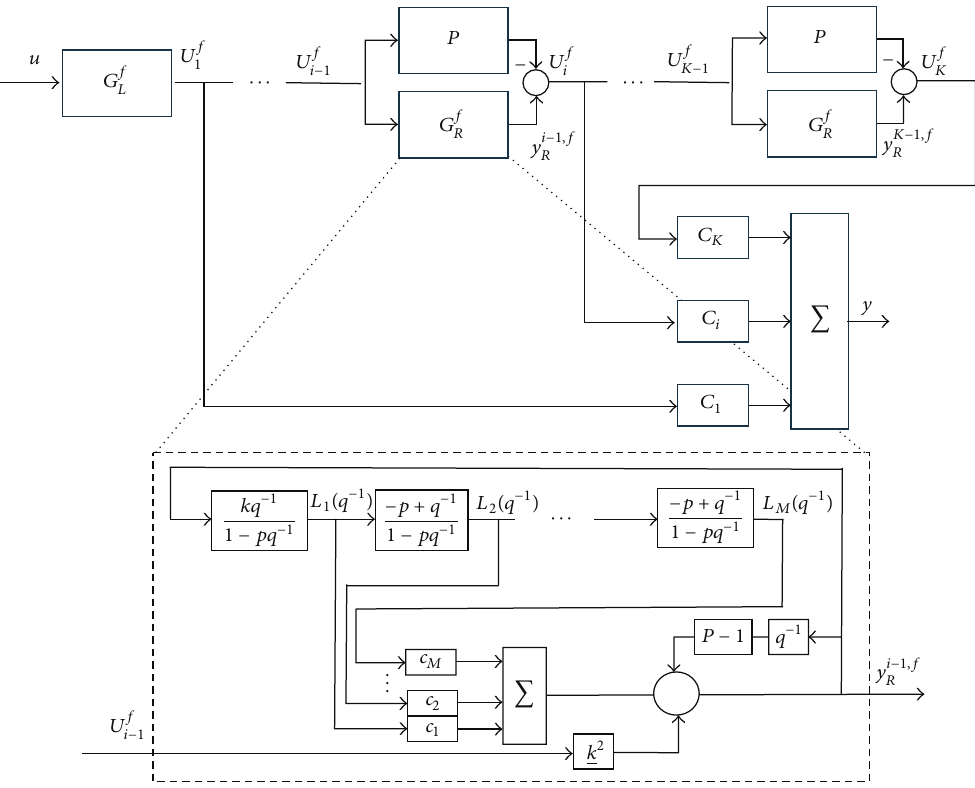
Figure 1: Block diagram of output calculation process for the FLD-based Laguerre